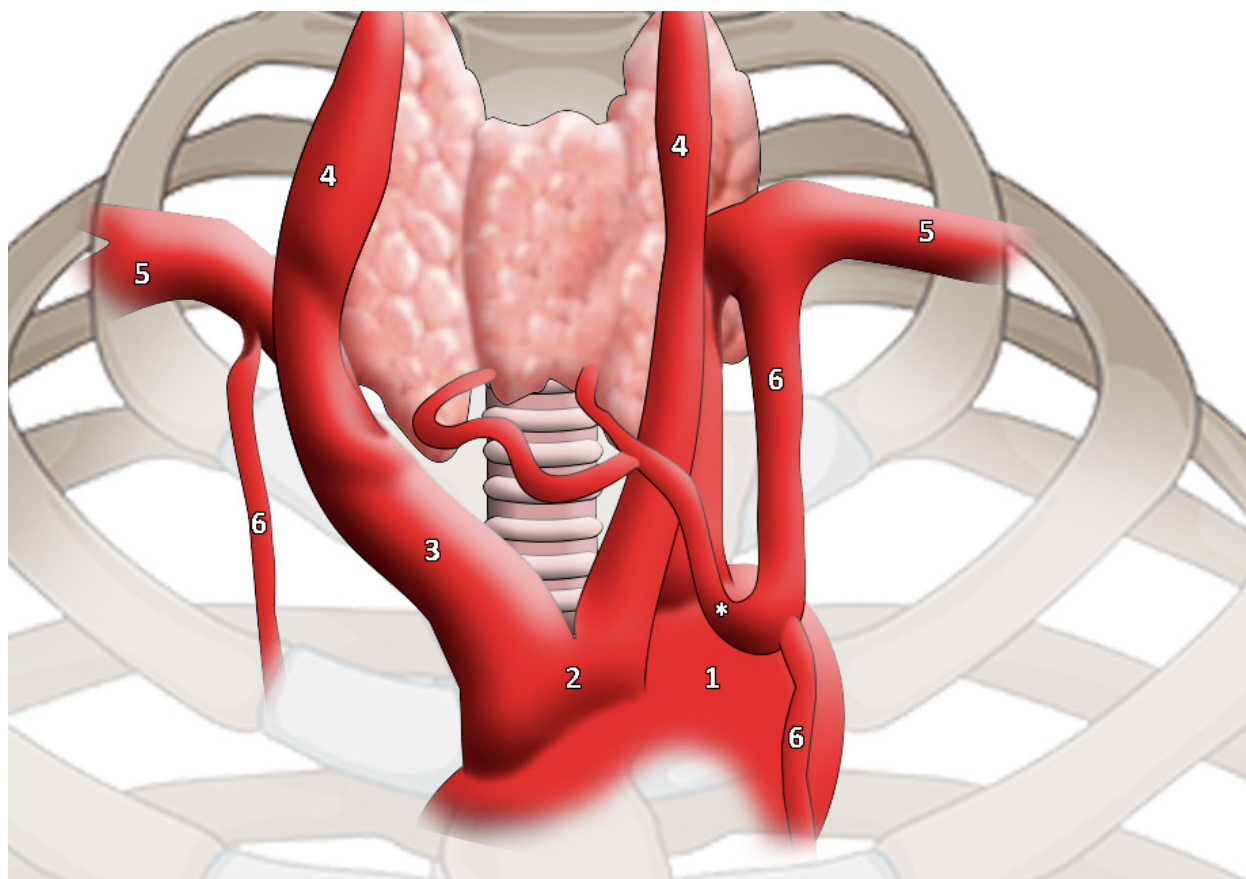
Figure 2. TIMA (highlighted by * asterisk) as reported and modified by Moriggl and colleagues. It is worth noticing the artery calibre [46]. 1, aortic arch; 2, common origin of innominate artery and left common carotid artery; 3, innominate artery; 4, common carotid artery; 5, subclavian artery; 6, internal thoracic artery.